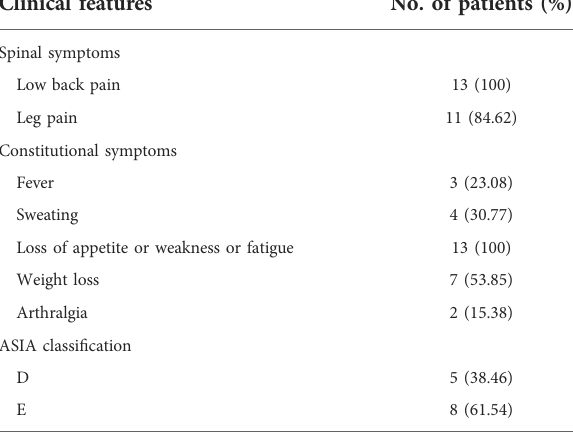
TABLE 4 Clinical features of all patients.